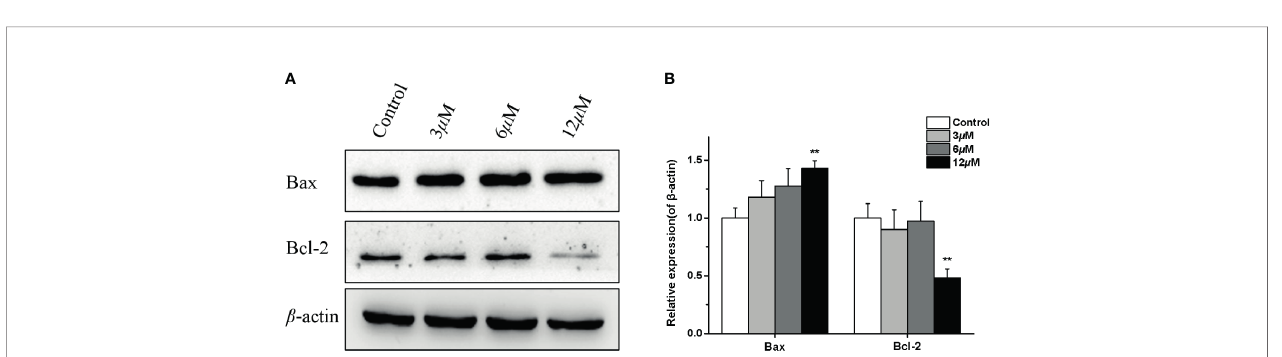
FIGURE 4 | Apoptosis effects of HepG2 cells induced by casearlucin A. HepG2 cells were treated with different concentrations (5, 10, and 15 m M) of casearlucin A for 48 h. DMSO was used as a negative control. Then, the cells were harvested, stained with Annexin V and propidium iodide (PI), and subsequently analyzed by fl ow cytometry. (A) Flow cytometric analysis of HepG2 cells after treated with different concentrations of casearlucin A. (B) Histogram of apoptotic cells at 48 h with the treatment of casearlucin A. Data from three separate experiments are expressed as means ± SD. *** p < 0.001 versus control group.